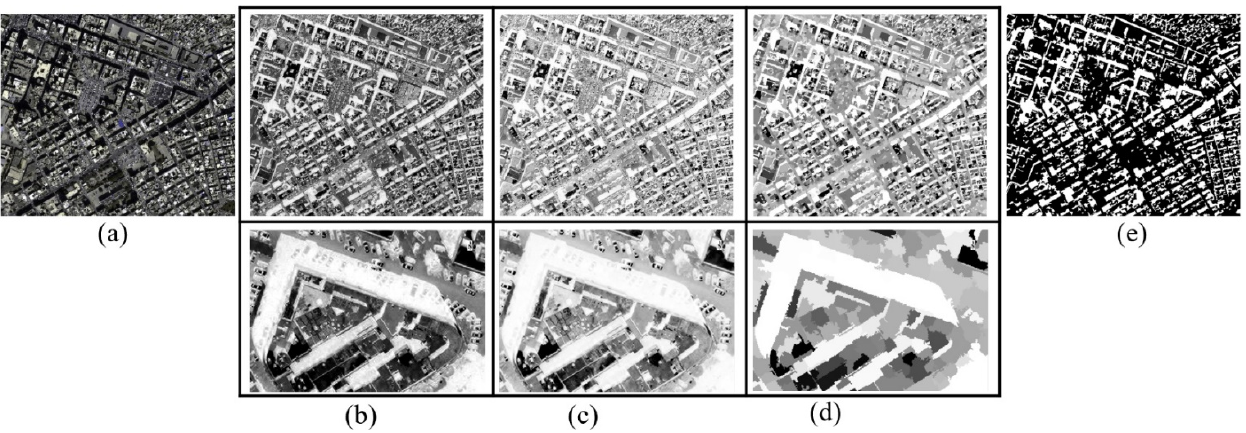
Figure 10. Experimental site 2: ( a ) original image shown with RGB bands; ( b ) result of shadow detection after threshold segmentation; the first rows of ( c – e ) are the results of SI, ISI and the reconstructed ISI, respectively; the second rows of ( c – e ) are the local enlarged view of SI, ISI and the reconstructed ISI, respectively. Table 2. The definitions of the